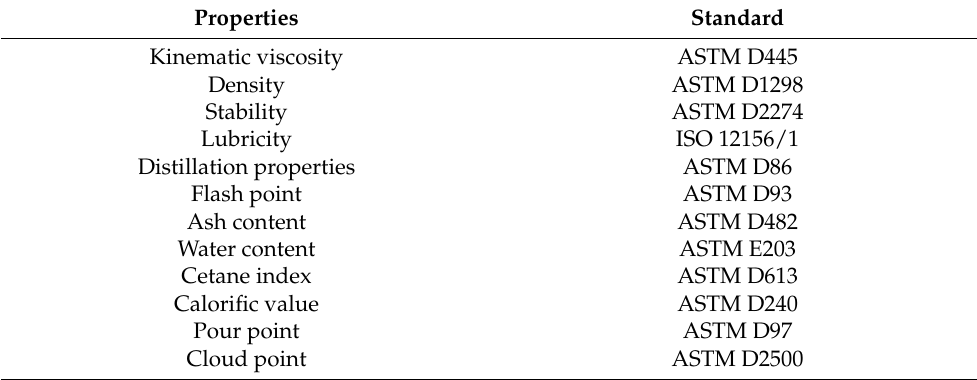
Table 6. ASTM and ISO standards for green diesel